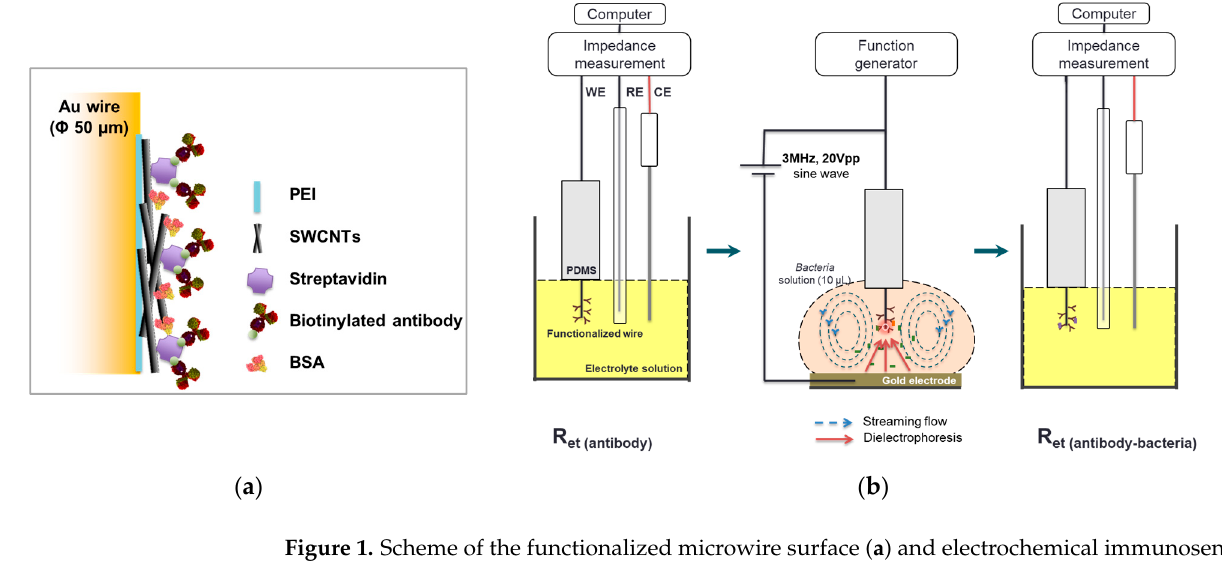
Figure 1. Scheme of the functionalized microwire surface ( a ) and electrochemical immunosensing with dielectrophoretic concentration ( b ).